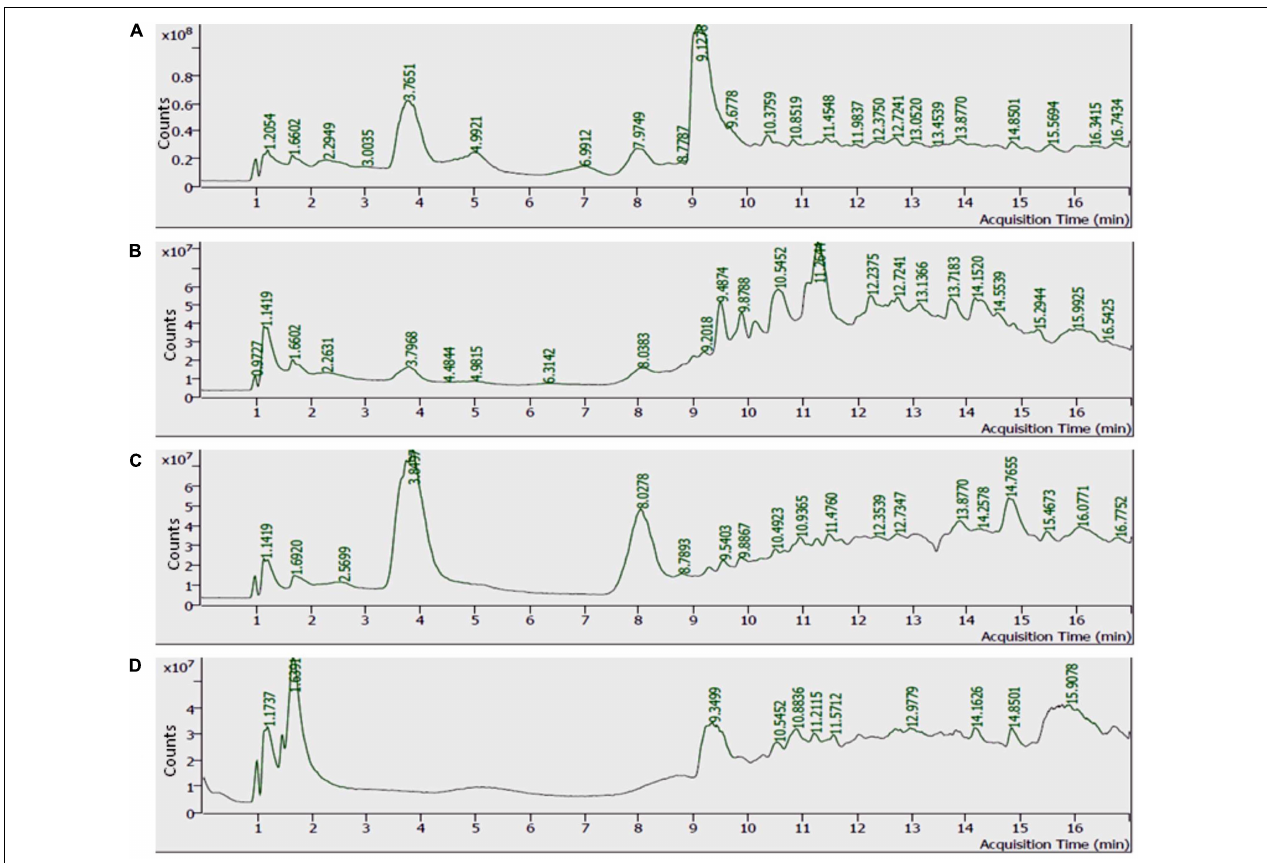
FIGURE 6 | Total ion chromatogram (TIC) of methanolic extracts. (A) Castor extract, (B) artemisia extract, (C) wheat extract, and (D) sorghum extract.